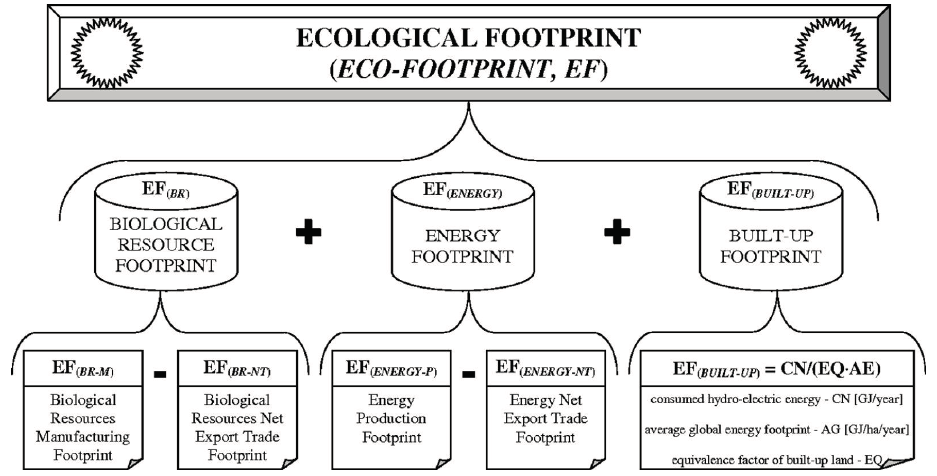
Figure 1. EF evaluation procedure based on Biological Resource Footprint, Energy Footprint and Build-up land Footprint (compiled from Fu et al. , 2015)